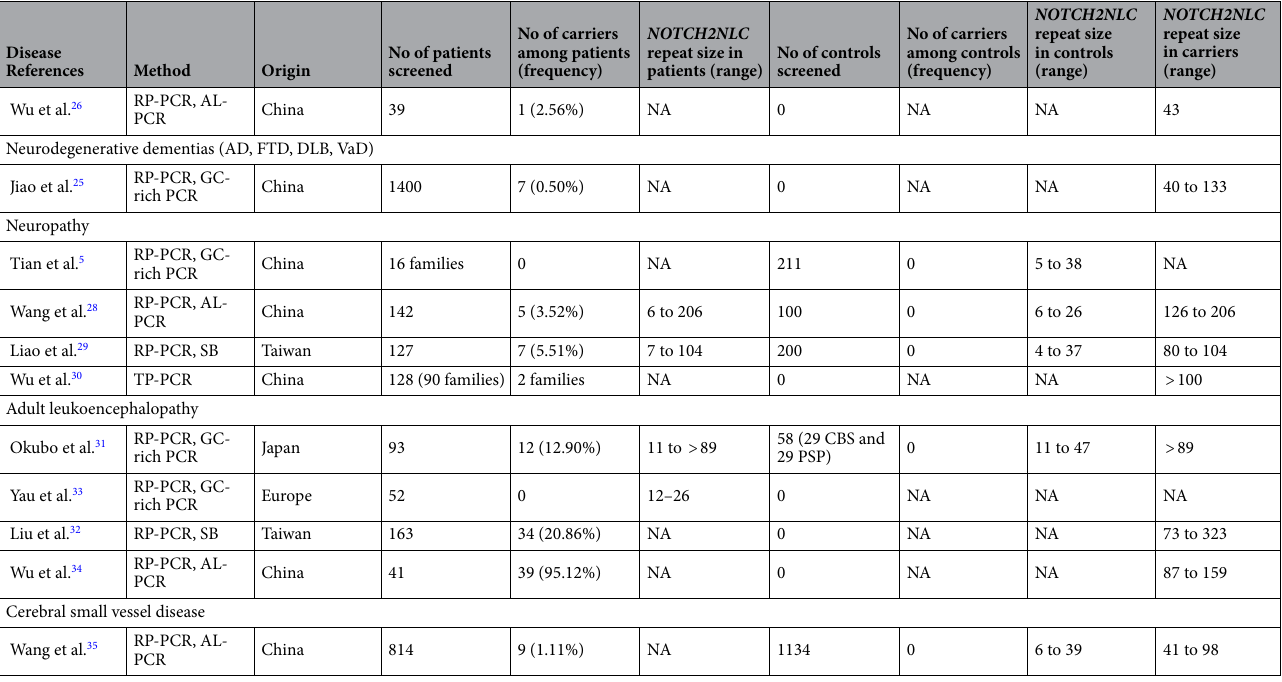
Table 1. Studies describing NOTCH2NLC GGC repeat expansion screening in neurological disorders. No number, MND motor neuron disease, ALS amyotrophic lateral sclerosis, HSP hereditary spastic